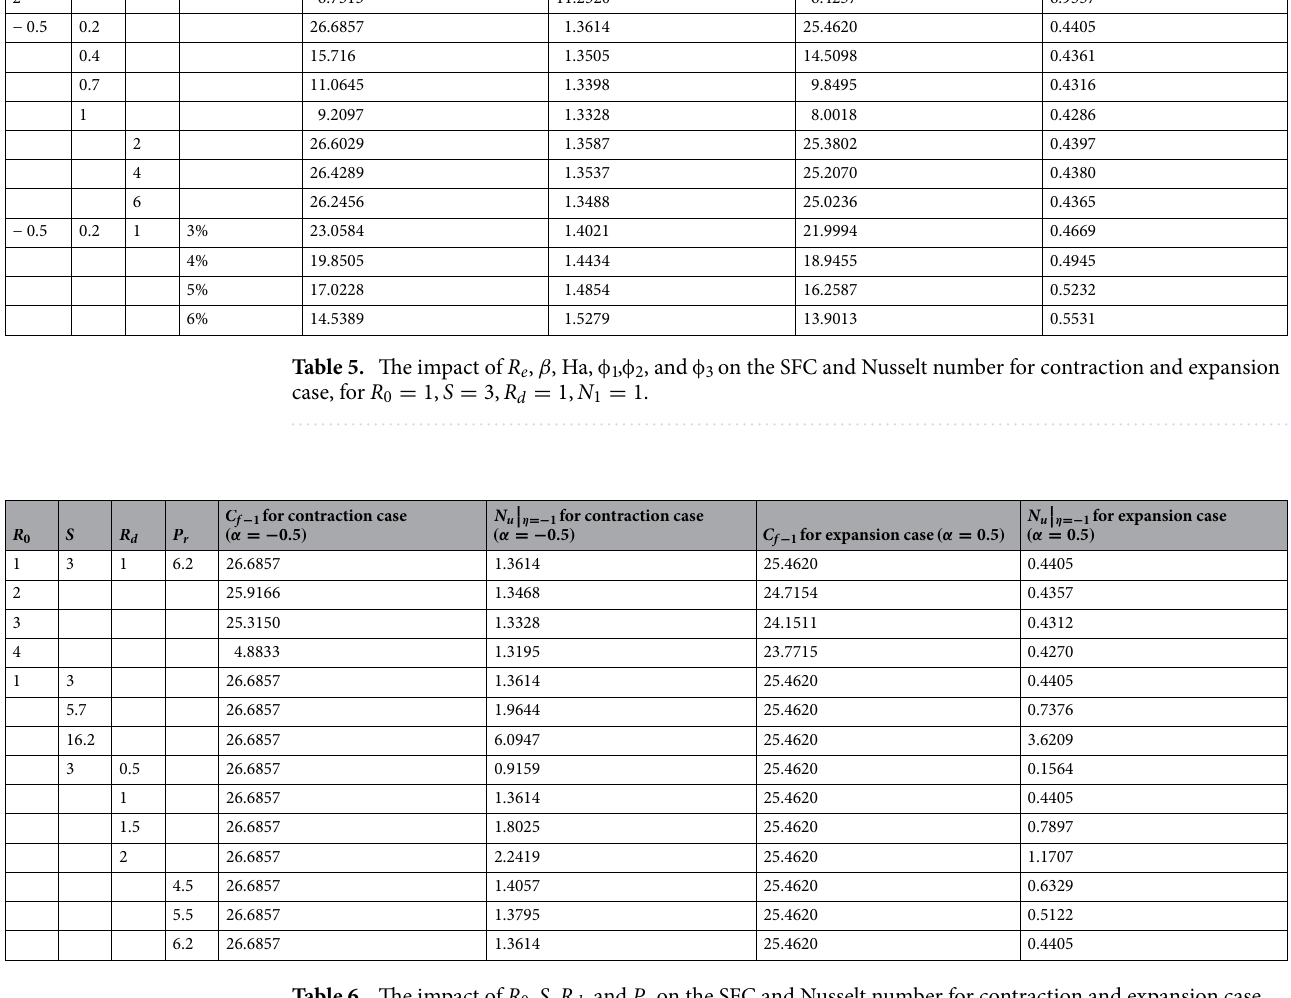
Table 6. The impact of R 0 , S , R d , and P r on the SFC and Nusselt number for contraction and expansion case, 0.2, m 1, Ha 1, φ 1 0.02 φ 2 φ 3 for β = = = = = =